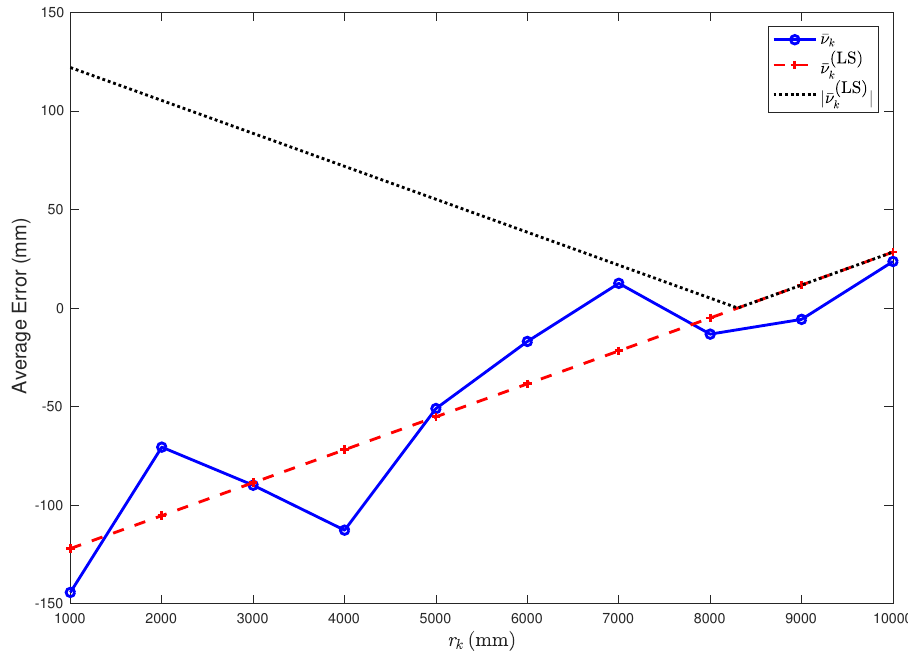
Figure 4. The values of the average range estimation error ¯ ν k (blue circles) and of its linear approximation ¯ ν ( LS ) (red pluses) are shown as functions of the true distance r k between the two k